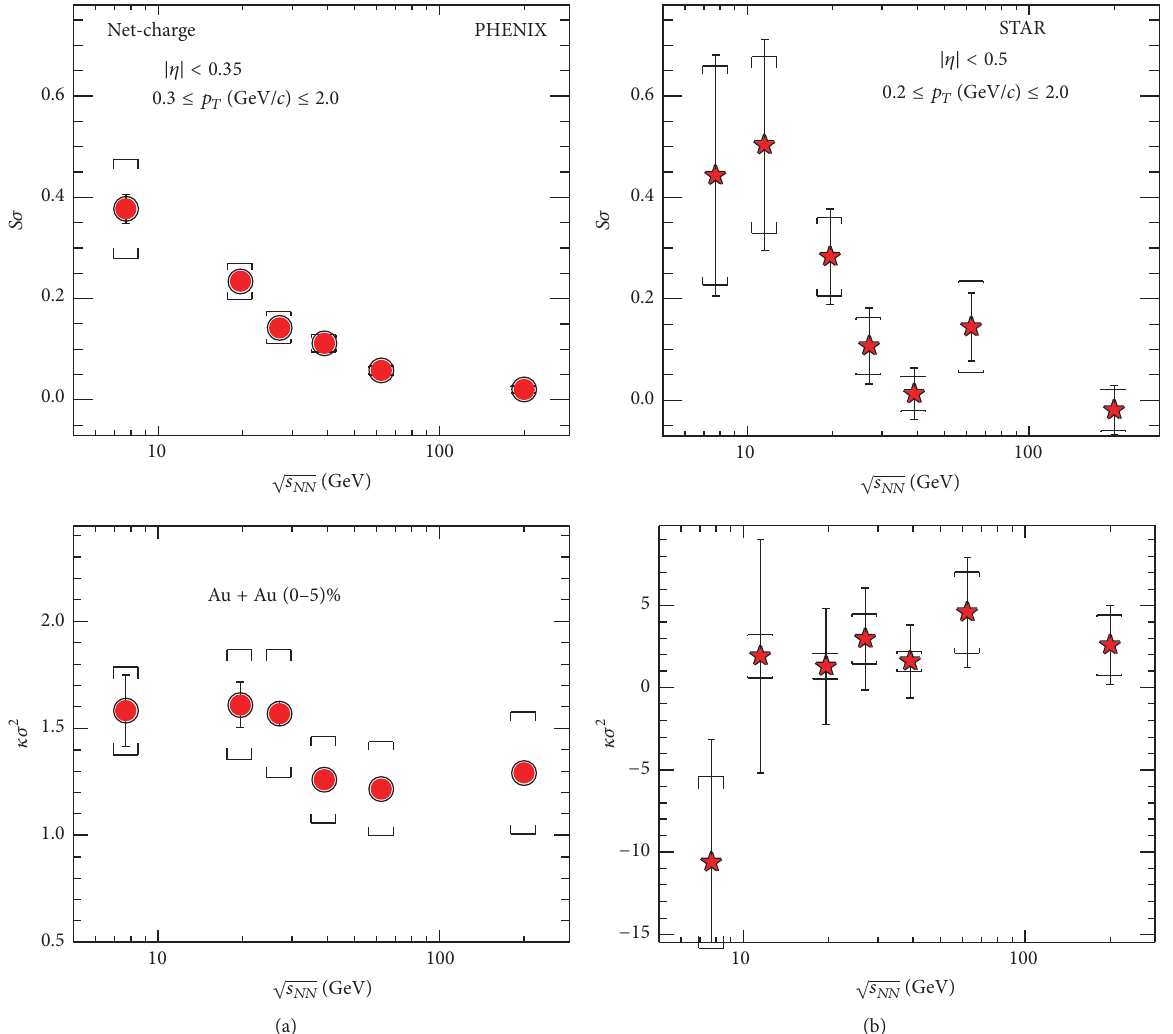
Figure 8: The energy dependence of efficiency corrected 𝑆𝜎 and 𝜅𝜎 2 of net-charge distributions for central (0–5%) Au + Au collisions at RHIC [64, 65]. The error bars are statistical and caps are systematic